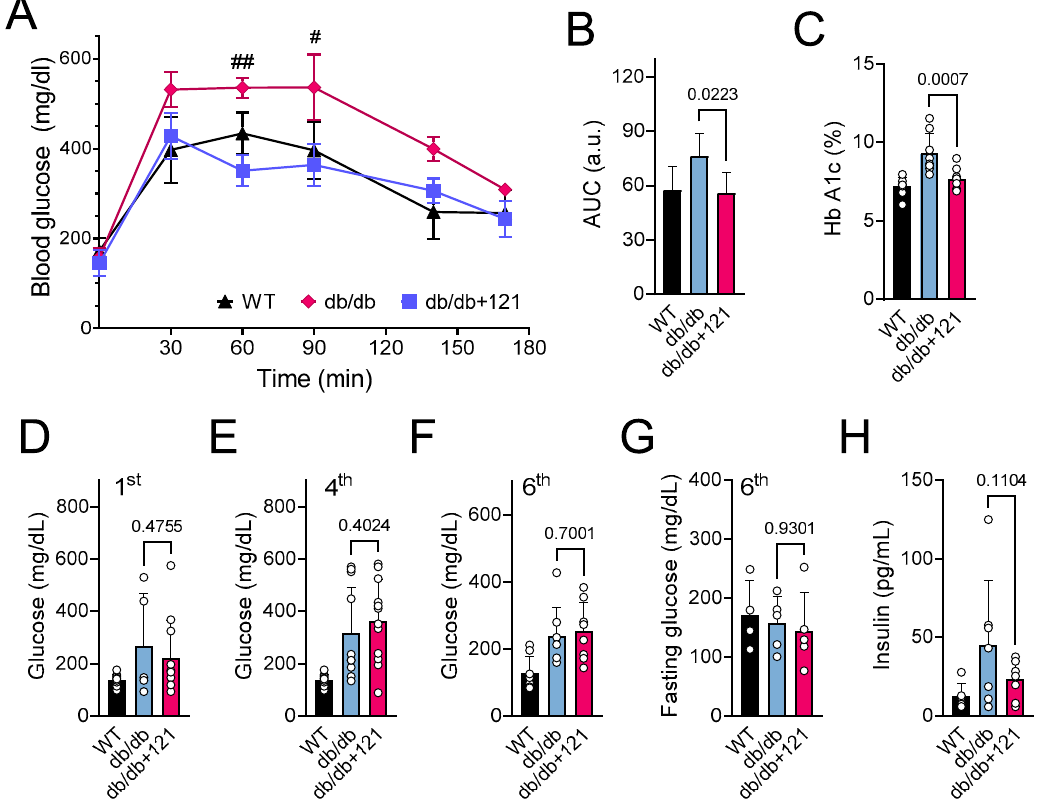
Figure 2. Glucose status in db/db mice that were untreated or treated with CMS121 for 6 months. ( A ) Glucose tolerance test (GTT, n = 4–5) and ( B ) area under the curve (AUC) were obtained at the